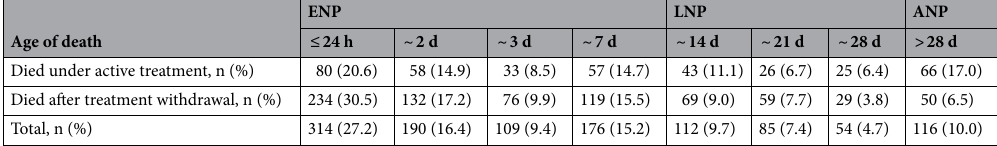
Table 7. Survival time of the nonsurvivors. ENP, early neonatal period; LNP, late neonatal period; ANP, after neonatal